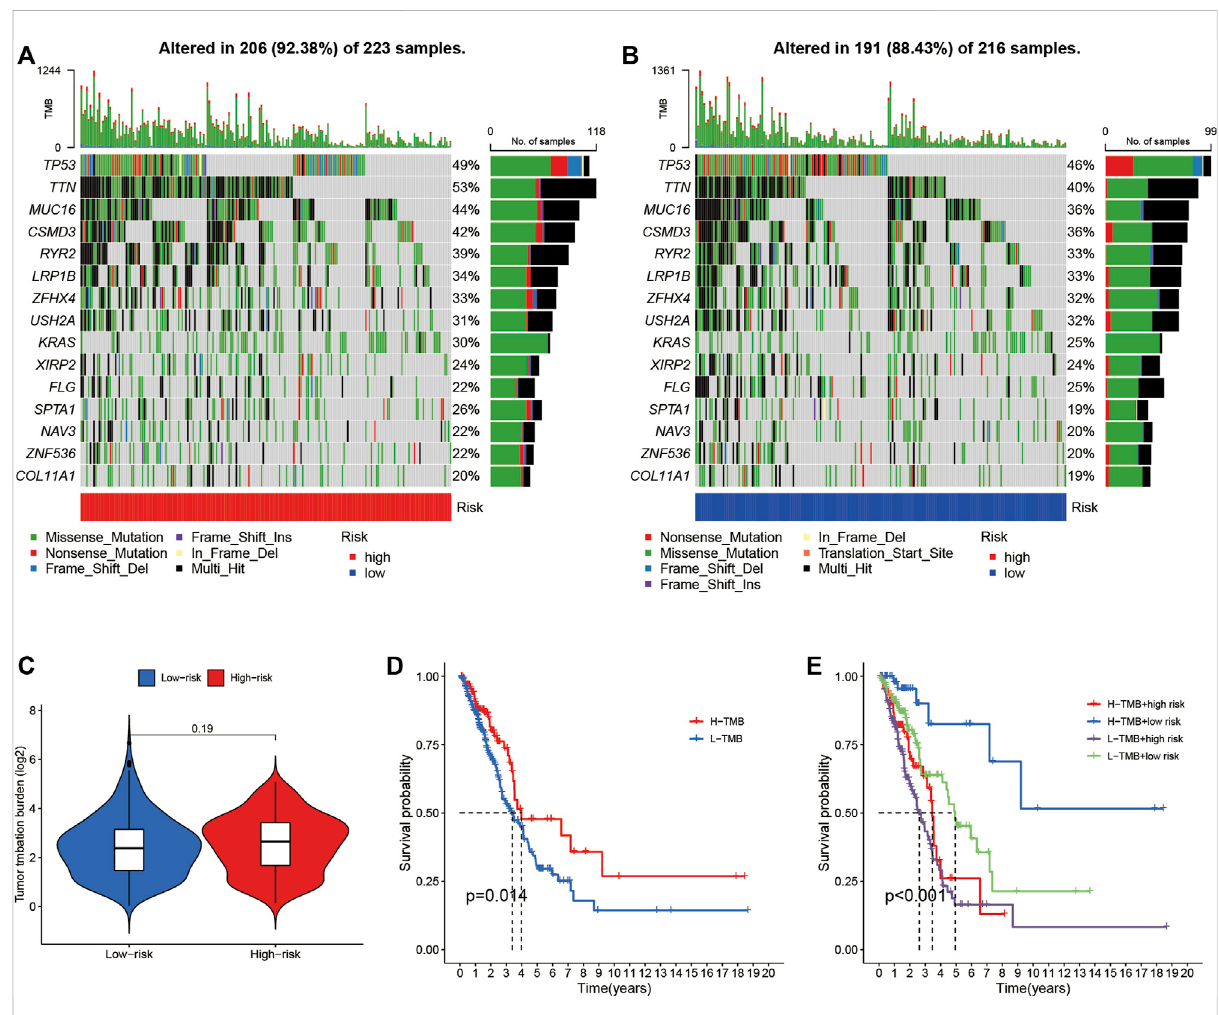
FIGURE 10 The relationship between LUADSenLncSig risk scores and somatic mutation and TMB in LUAD tissues. Waterfall plot showing the somatic mutations between high- (A) and low-risk (B) LUAD patients. (C) Difference of TMB between patients from the low- and high-risk score subgroups. (D) Kaplan – Meier curves for the high-and low-TMB groups. (E) Kaplan – Meier curves for patients strati fi ed based on both TMB and risk scores. The p -valuerepresentstheANOVAtestbetweenthesubgroups.